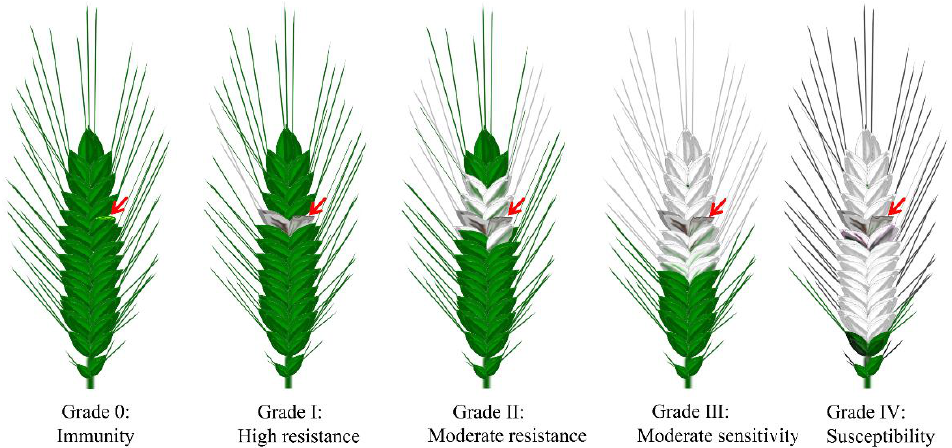
Figure 2. Grades of resistance to and severity of FHB in wheat. According to the severity of FHB on wheat spikes, the severity of the disease and the resistance level of the plant were divided into five grades: grade 0, I~IV, which represents the percentage of diseased spikelets as zero, less than 1/4 (<25%), 1/4~1/2 (26–50%), 1/2~3/4 (51–75%), and more than 3/4 (>75%) in turn. Meanwhile, the numbers also correspond to the different FHB resistance levels of the plant. (Please refer to the detailed information in GB/T 1576-2011 of China). Red arrows indicate sites inoculated with Fg .